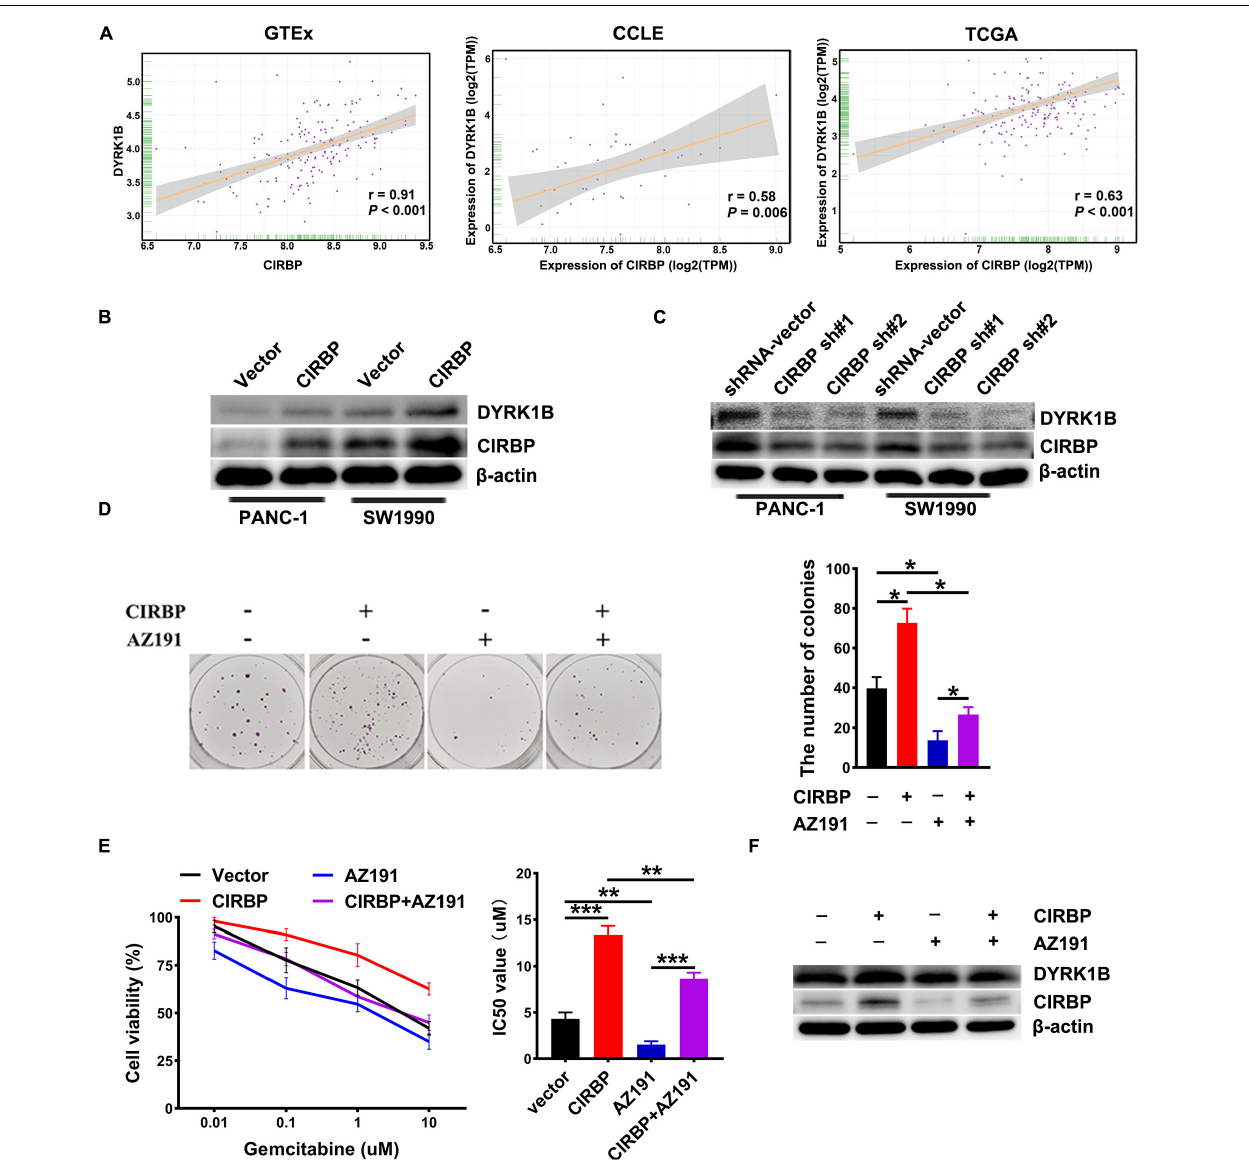
FIGURE 6 | CIRBP rends pancreatic cancer cell resistance to Gemcitabine treatments by upregulating DYRK1B expression. (A) Three publicly available databases were used to explore the potential interaction factors of CIRBP. The Cancer Genome Atlas (TCGA) and Genotype-Tissue Expression (GTEx) datasets include RNA-Seq data for tens of thousands of tumors and normal tissues; the Cancer Cell Line Encyclopedia (CCLE) dataset provides a variety of cancer cell-line RNA-Seq data. Data were analysis using Pearson’s rank correlation analysis. (B) The expression of DYRK1B in CIRBP overexpressed PANC-1 and SW1990 cells was analyzed by Western blot. (C) The expression of DYRK1B in CIRBP knockdown PANC-1 and SW1990 cells was analyzed by Western blot. (D) Representative images and quantification of colonies in CIRBP overexpressed PANC-1 cells with or without AZ191 (5 µ M for 48 h) treatments. AZ191 is a novel selective kinase inhibitor of DYRK1B. (E) AZ191 treatments enhanced the sensitivity of PACN-1 cells with CIRBP overexpression to gemcitabine treatments. (F) The expression of CIRBP and DYRK1B in CIRBP overexpressed PANC-1 cells with or without AZ191 treatments was analyzed by Western blot. Data are presented as means ± SD. * P < 0.05, ** P < 0.01, *** P < 0.001, unpaired student’s t